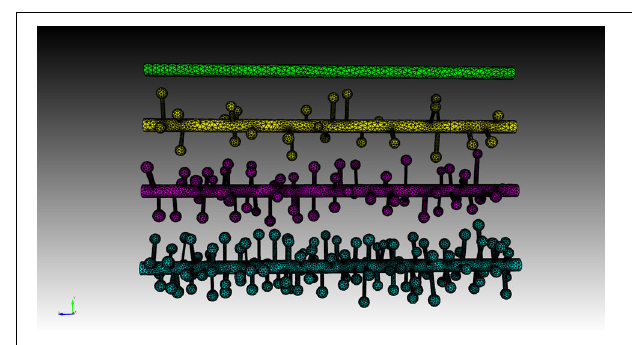
FIGURE 8 | Meshes of simplified dendrites with different spine densities. Spine density for each mesh (in top–down order): 0, 2, 4, 8 spines/ µ